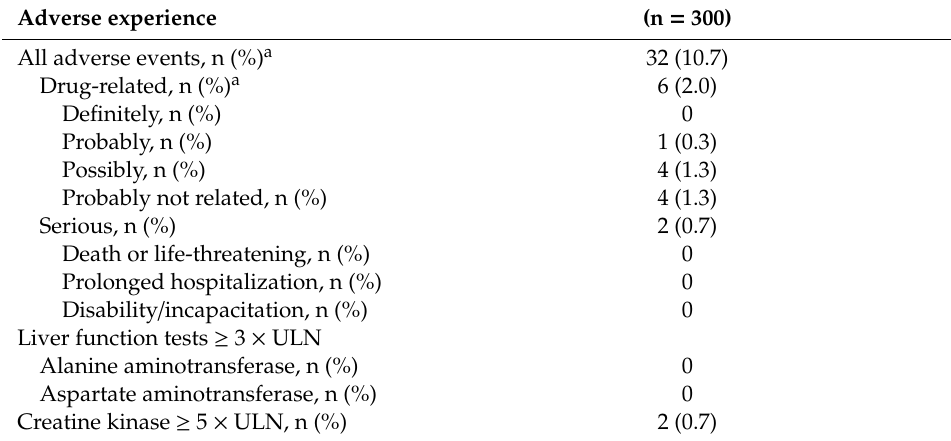
Table 7. Safety endpoints: adverse